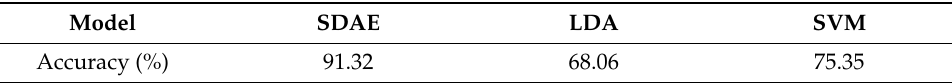
Table 8. Performance evaluation results of classification models.